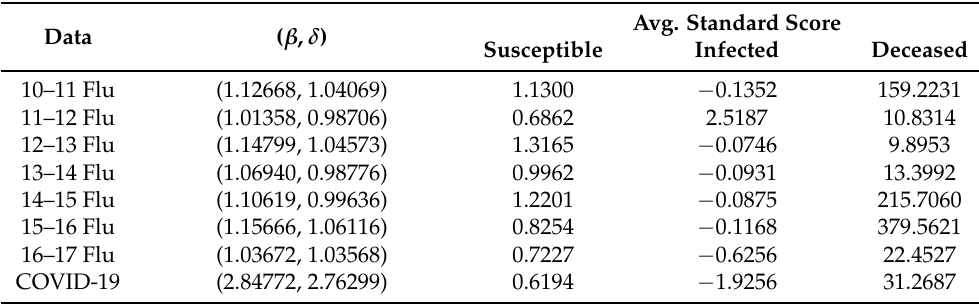
Table 1. Rate values obtained for corresponding influenza seasons, and the first 100 days since first infection in Manhattan,